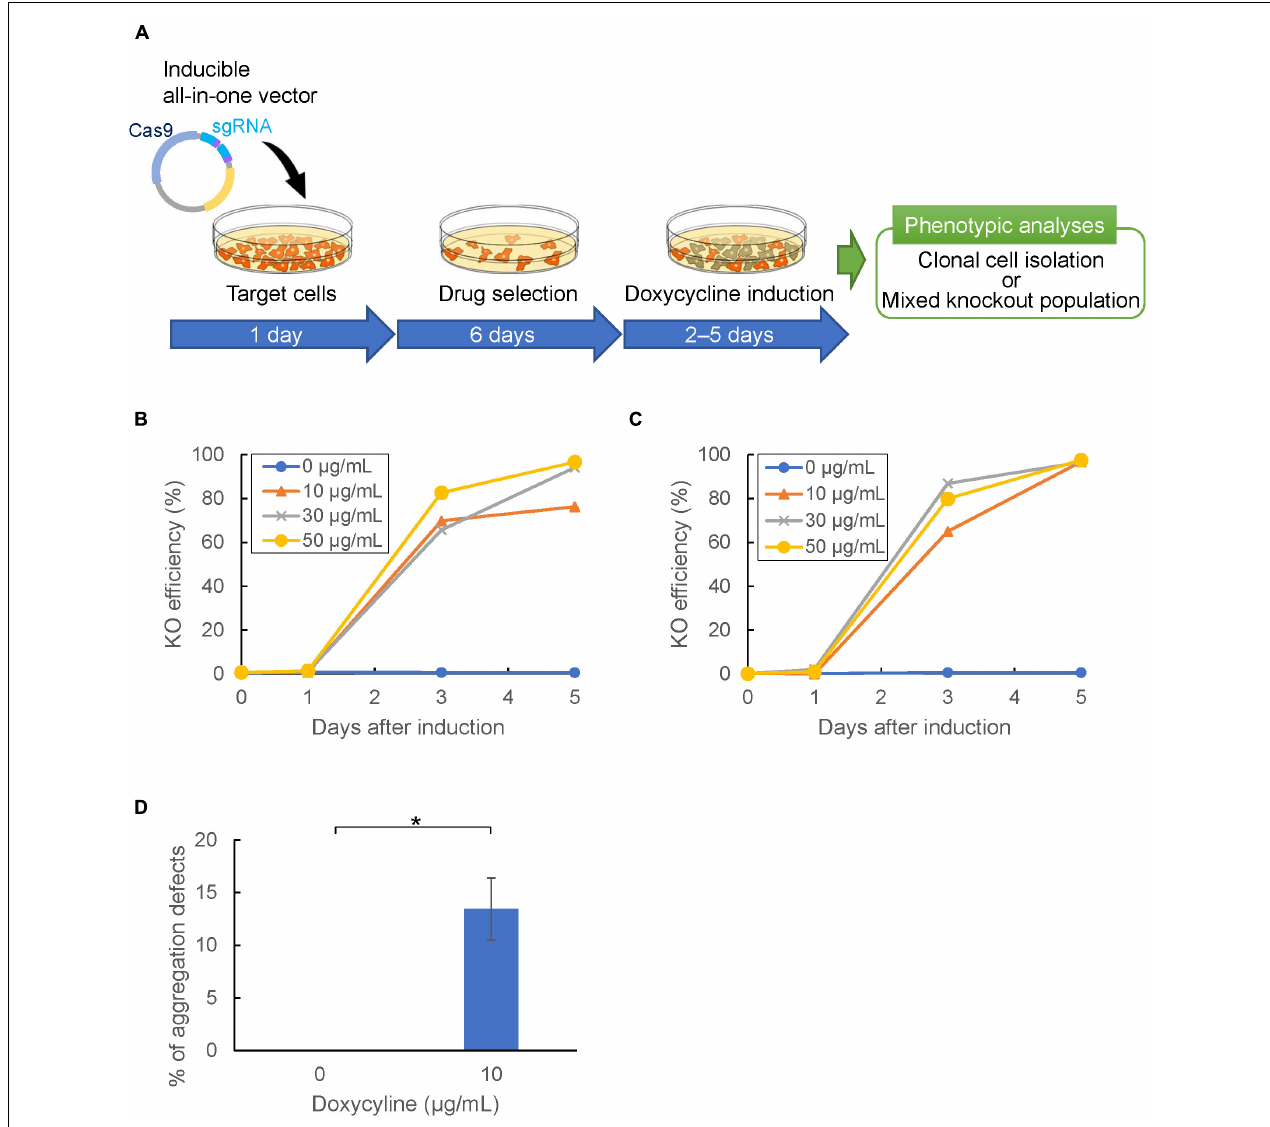
FIGURE 6 | Temporal control of CRISPR/Cas9-mediated gene knockout. (A) Gene knockout workflow using inducible all-in-one vector. Target cells were transformed with the inducible vector and selected with Blasticidin or G418 in doxycycline-free HL5 for 6 days. Cas9-stable cells were then incubated in HL5 with doxycycline to induce Cas9. (B,C) Temporal control of genome editing via inducible Cas9 vector containing neomycin (B) or blasticidin (C) resistance cassette, respectively. The mean of knock-out efficiency at different doxycycline concentrations (0, 10, 30, 50 µ g/mL) was represented. (D) Frequency of aggregation defect mutants targeting pkaC gene at different doxycycline concentrations. The error bar shows the standard deviation based on four independent biological replicates. * P <